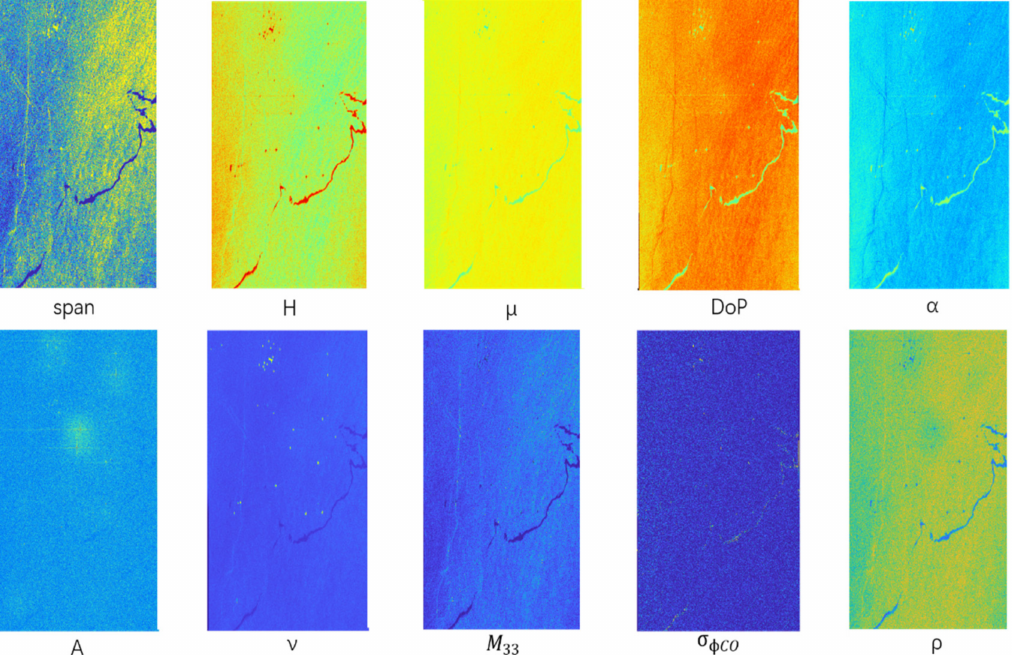
Figure 5. Presentation of ten prominent polarimetric features of image 2 by PolSARpro software and